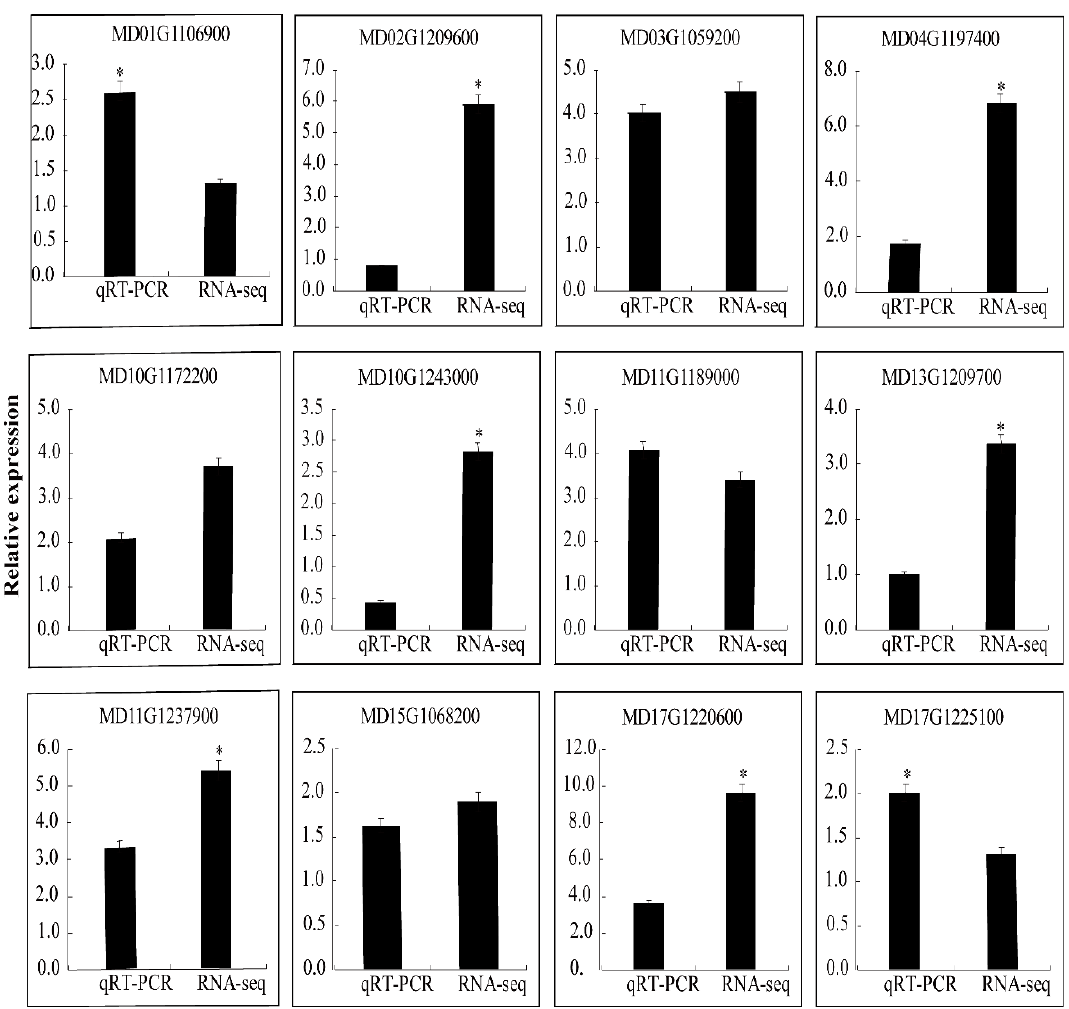
Figure 6. qRT ‐ PCR validation of differential gene expression. The “*” indicate significant difference Figure 6. qRT-PCR validation of di ff erential gene expression. The “*” indicate significant di ff erence at at p < 0.05. p <